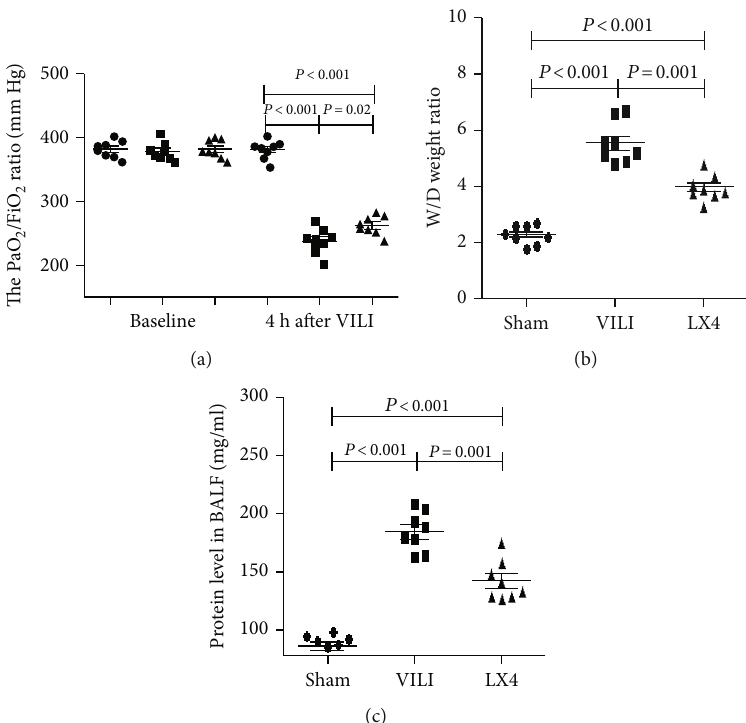
Figure 1: Lipoxin A4 improved alveolar-capillary permeability in VILI. Compared to the sham group, the PaO wet/dry weight ratio and protein levels in BALF were increased in the VILI and LX4 groups. Compared to the VILI group, the PaO increased (a), and the wet/dry weight ratio (b) and protein concentration (c) were decreased by lipoxin A4. ∗ P < 0 : 05 , vs. the sham group; # P < 0 : 05 , vs. the VILI group. ● : sham group; ■ : VILI group; ▲ : LX4